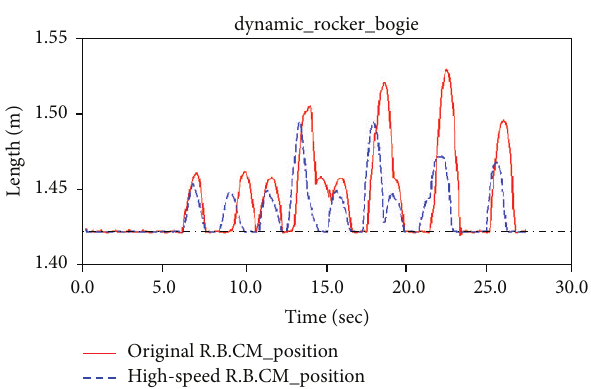
Figure 6: Vertical position variation of the vehicle’s CM.